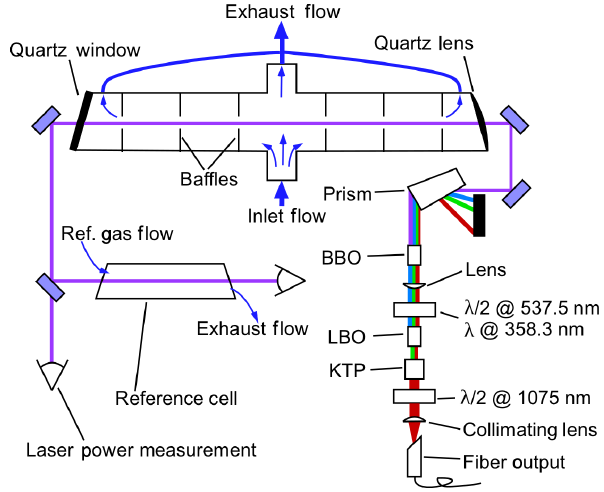
Figure 1. Schematic of the free-space optical layout. The fluores- cence collection optics, bandpass filters, and PMTs for both the measurement and reference cells are located above this plane and are omitted for clarity. These components are located above the cen- ter of each cell and image light from the center of the cells onto the PMTs. In the measurement cell, most of the sample air passes straight through the cell to quickly flush the volume in the middle of the cell that is imaged onto the PMT. A minor fraction of the sample air is drawn out through the arms of the LIF cell to reduce dead volumes in the measurement